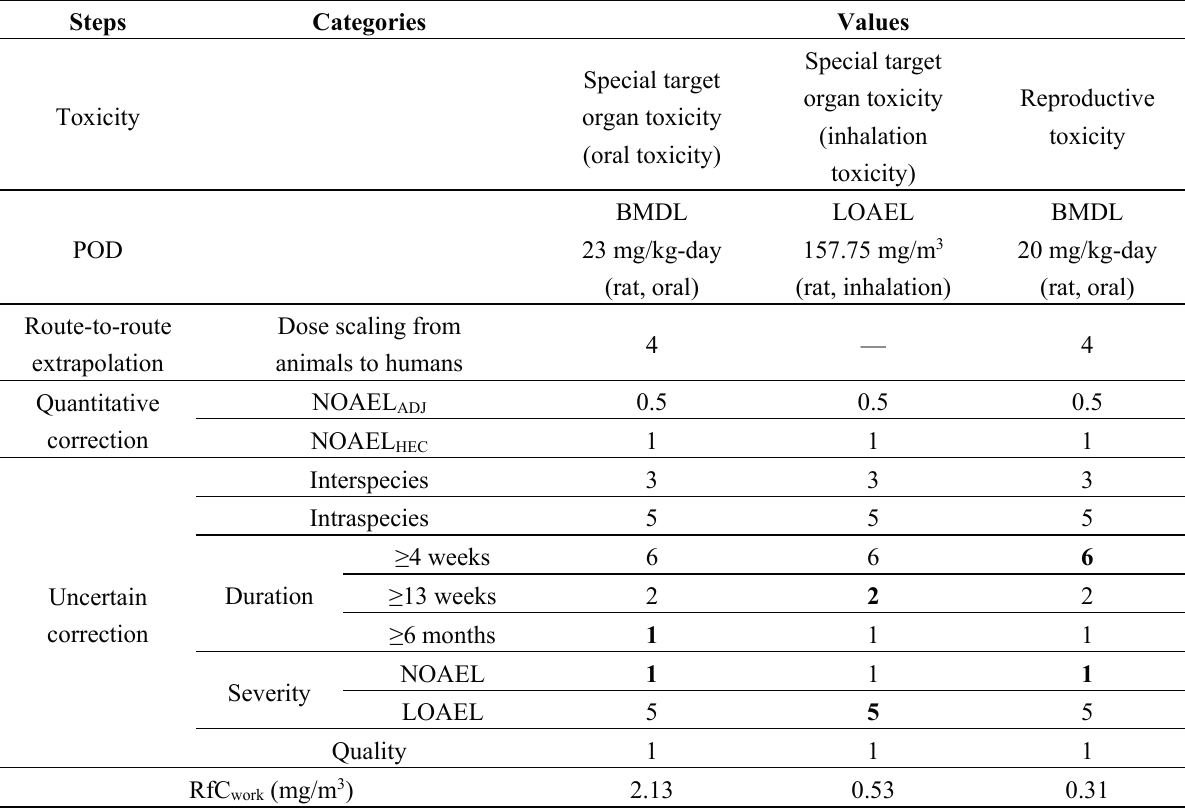
Table 3. Reference values for non-carcinogenic dose-response assessment of